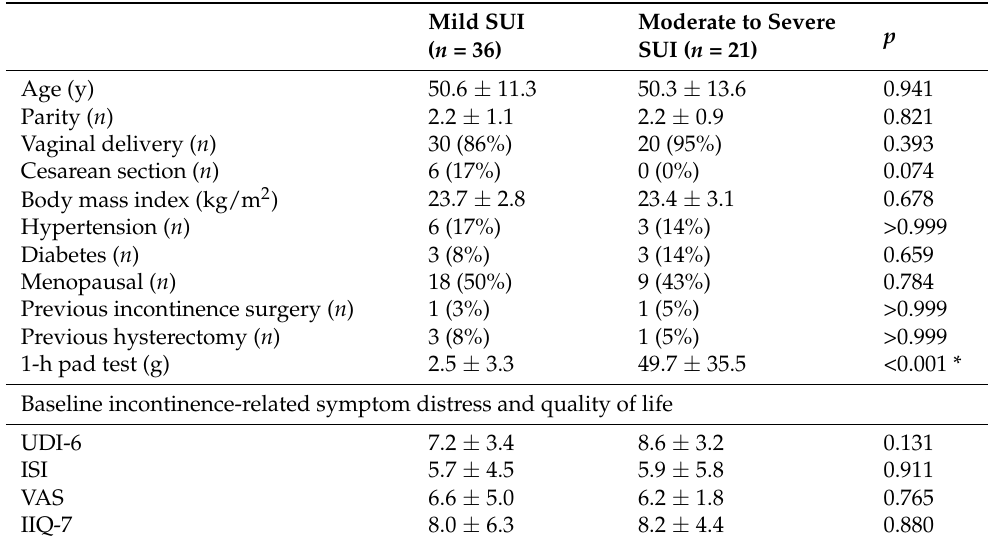
Table 1. Demographic characteristics of the women who underwent biofeedback and electrostimulation- assisted pelvic floor muscle